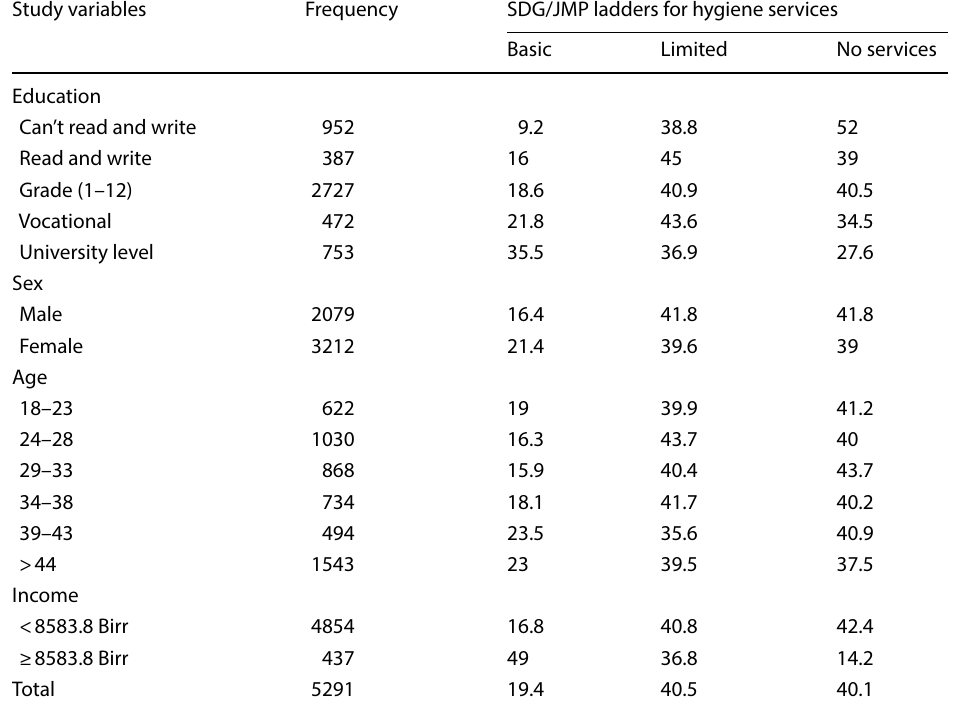
Research Table 3 Percentage of hygiene service ladders of households by sociodemographic characteristics of